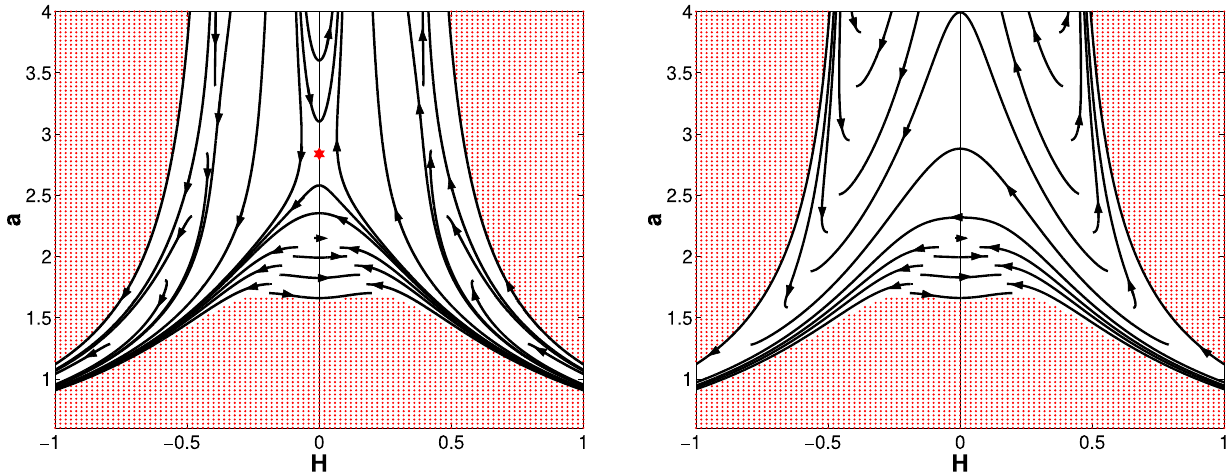
Fig. 4 The phase portraits are plotted for N = 3, f 0 = − 1 dotted regions correspond to ρ < 0 in the constraint equation (11) Fig. 5 Two parts of the phase portrait are plotted for N = 2, f 0 = 1 , k = − 1, w = 0 . 5. The 3 star denotes the stationary point. The dotted zones correspond to ρ < 0 in the constraint equation